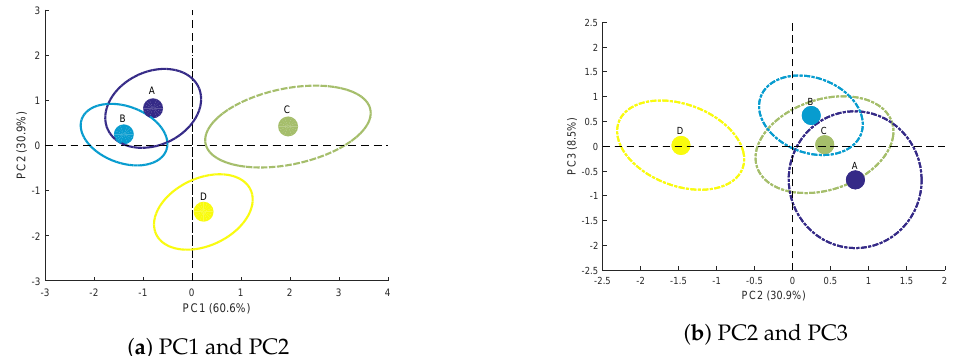
Figure 8. Average scores and confidence ellipses of the calibration set for each genotype on the principal components of the genotype